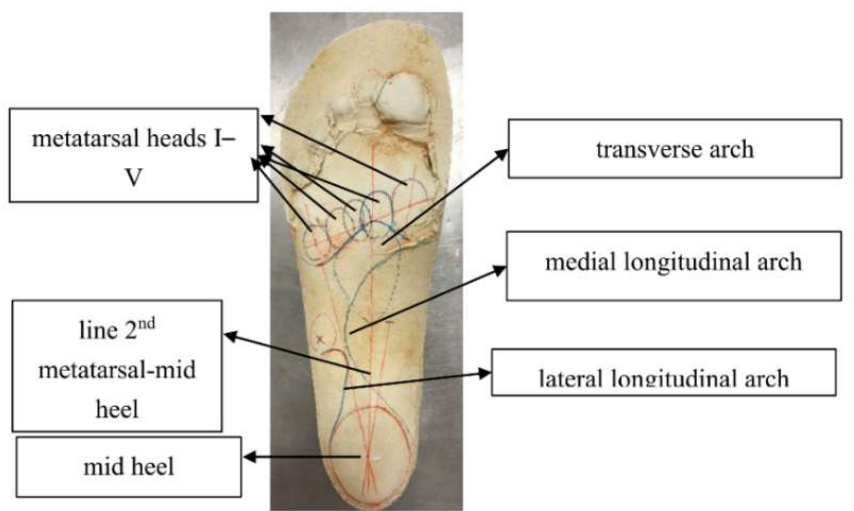
Figure 1. Positive foot mold for making customized foot orthosis.